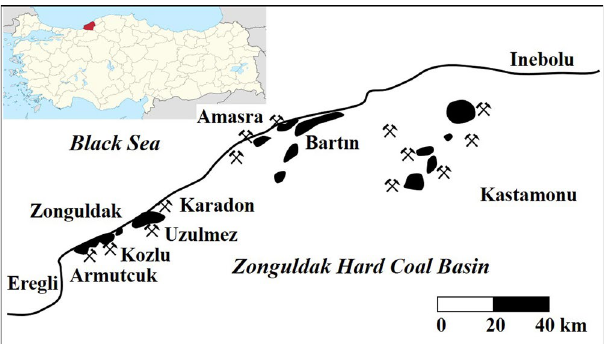
Figure 1. Location of the mine collieries in the Zonguldak hard coal